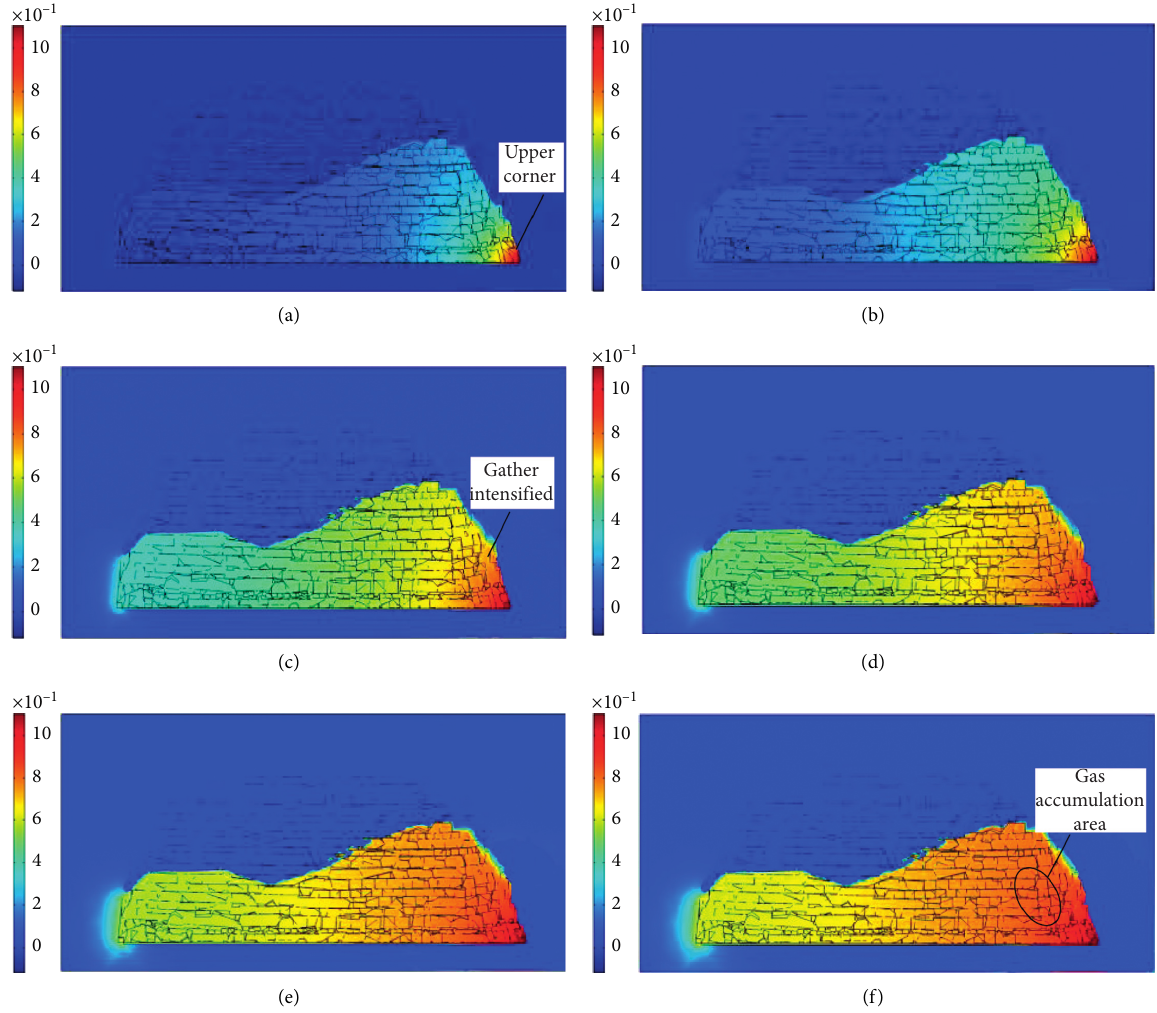
Figure 9: Distribution and variation of gas concentration in fracture field. (a) t � 10h. (b) t � 20h. (c) t � 50h. (d) t � 60h. (e) t � 90h. (f) t � 100h.